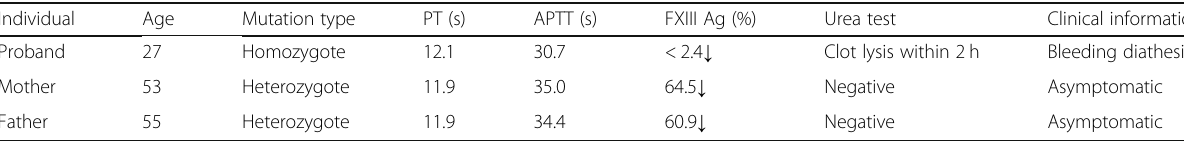
Reference ranges: PT, 10.0 – 16.9s; APTT, 20.0 – 43.5s; FXIIIAg (%), 75 – 155%